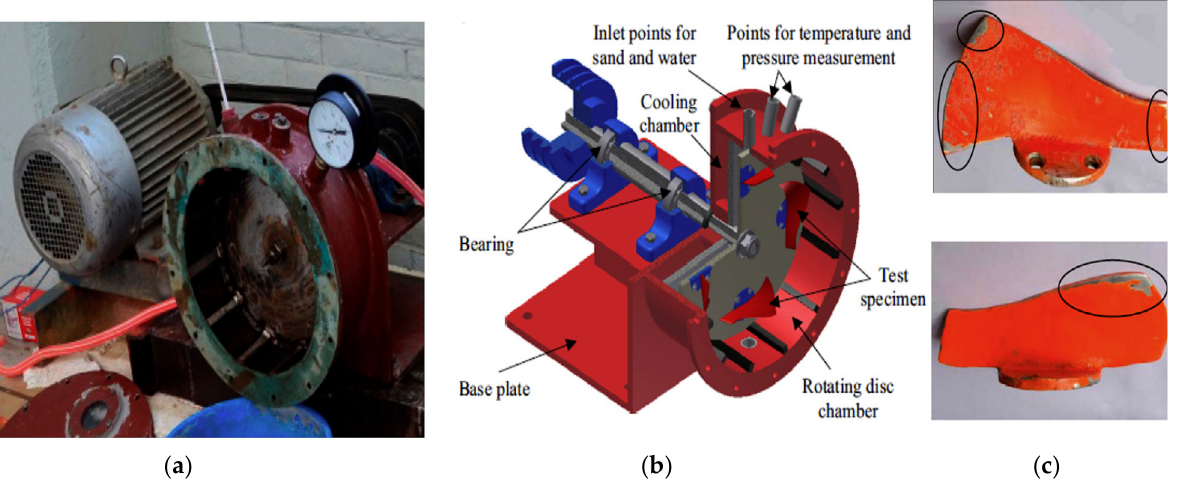
Figure 4. ( a ) Rotating disc apparatus (RDA) apparatus; ( b ) apparatus components; ( c ) erosion behavior observed on the blade [13].